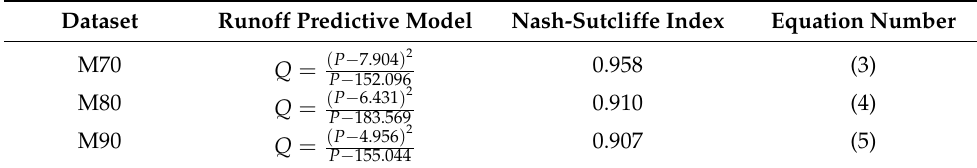
Q = runoff depth (mm), P = rainfall depth (mm).